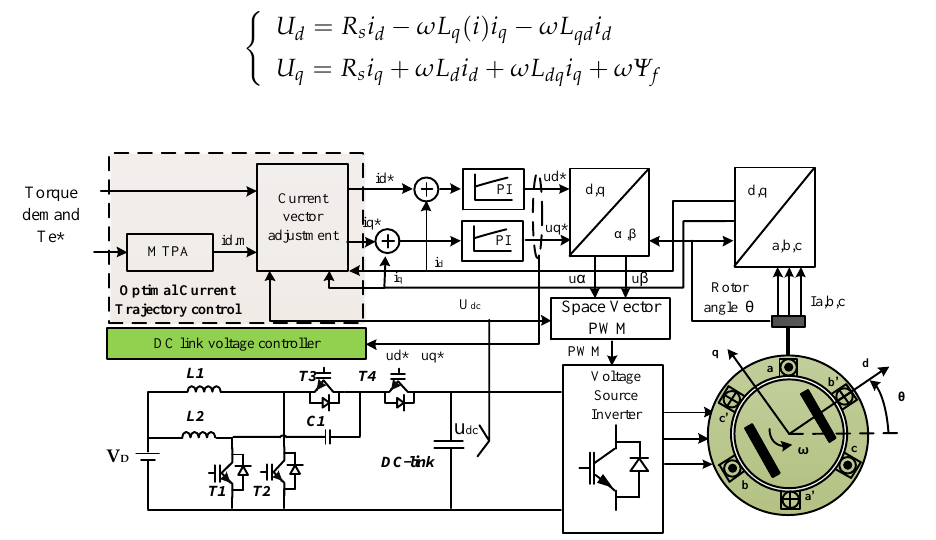
Figure 5. The overview of the dynamic DC-link voltage control strategy.